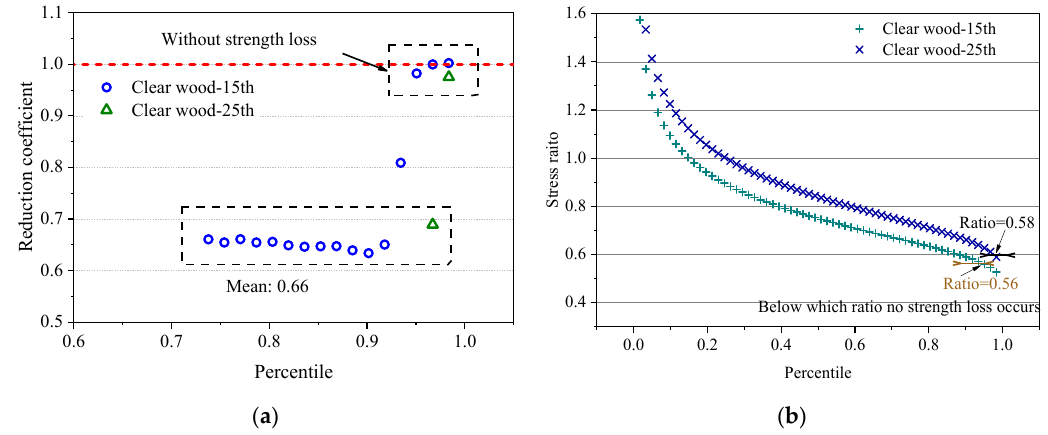
Figure 9. Test results of clear wood. ( a ) Strength reduction coefficient of the survivals, ( b ) Stress ratios of all specimens.